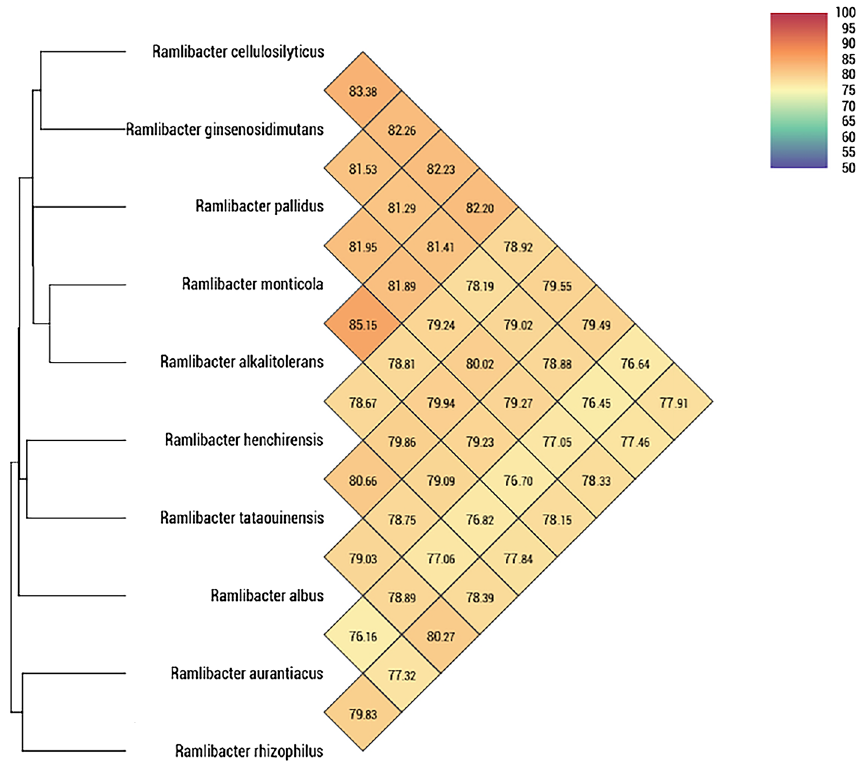
Figure 3. Heatmap of strains USB13 T , AW1 T , GTP1 T , and HM2 T and other closely related strains within the genus Ramlibacter , generated with OrthoANI values calculated using OAT software 45 . Bacterial strains and accession numbers are indentical to those of Fig. 2.